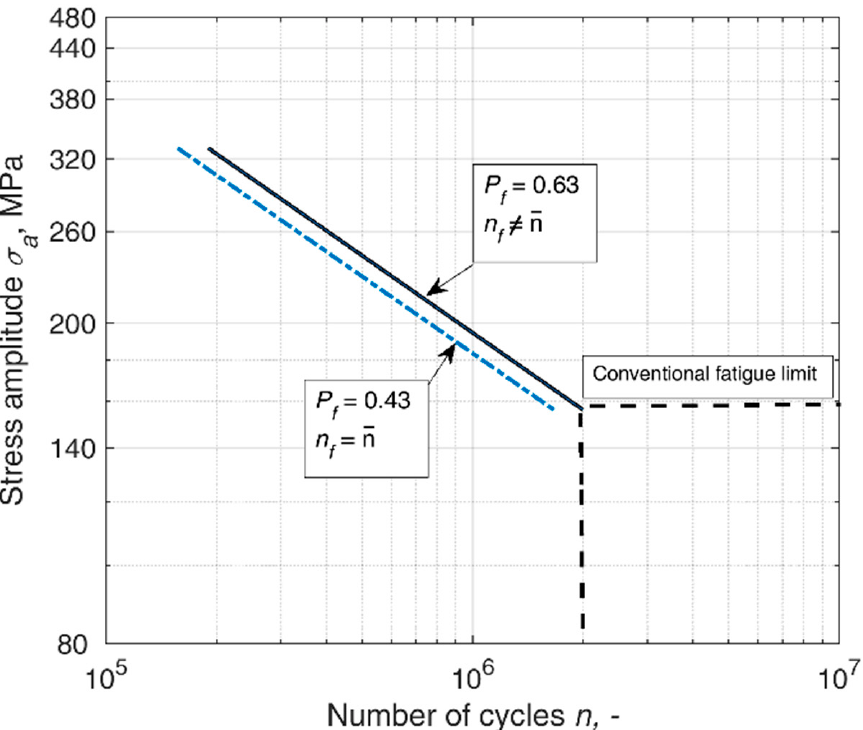
Figure 2. An example s-n curve of fatigue lives and the corresponding probability of failure in the Equation (6) Weibull formulation of life distribution. Mean fatigue lives correspond to the s-n curve shifted to P f = 0.43.